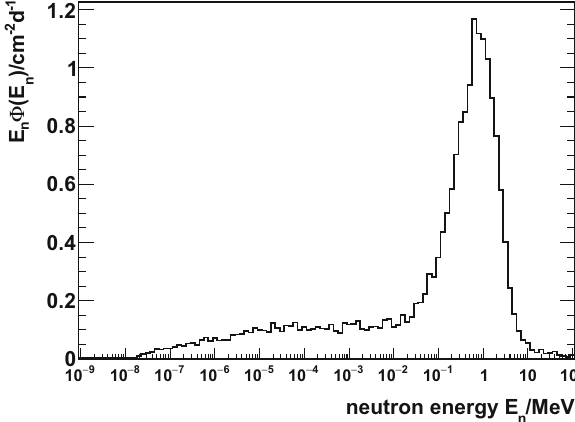
Fig. 9 Simulated muon-induced neutron fluence rate at a CONUS diode within the CONUS shield at KBR. Most of the neutrons are fast, with energies around 1MeV, creating recoils in Ge ground model is evaluated by comparing the combination of all scaled MC background contributions to the measured data as discussed in Sect.5. It is estimated to be (97.0 ±